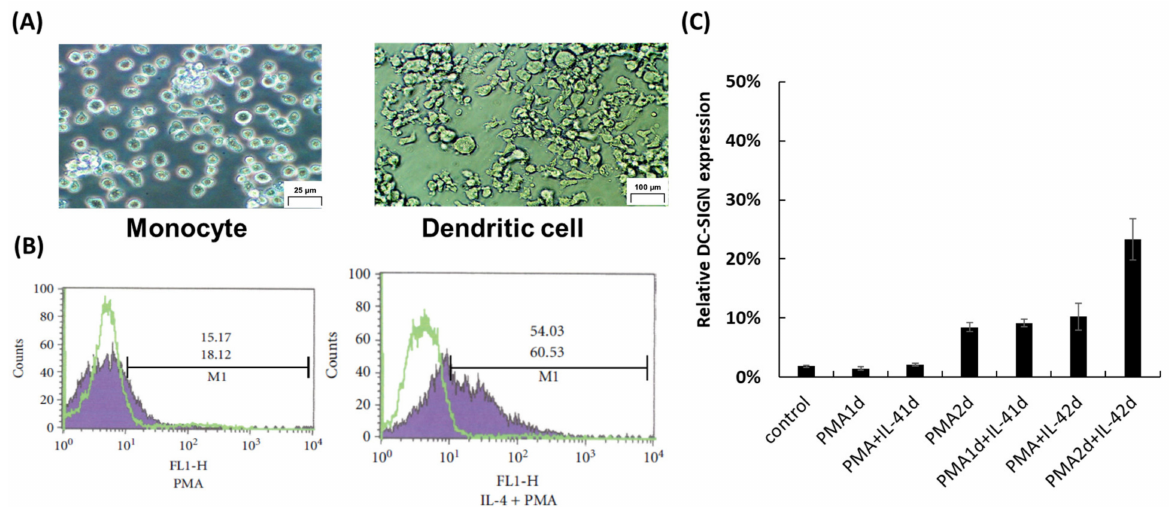
Figure 1. ( A ) Differentiation of monocytic THP-1 cells into dendritic-like THP-1 cells (THP-1 DC) by treatment with phorbol 2-myristate 13-acetate (PMA) and interleukin-4 (IL-4). ( B ) Expression of DC-specific ICAM-3-grabbing nonintegrin (DC-SIGN) on the surface of THP-1 DC was evaluated by flow cytometer using anti-DC-SIGN antibody. ( C ) Quantification of THP-1 cells expressing DC-SIGN on their cell surfaces after PMA and IL-4